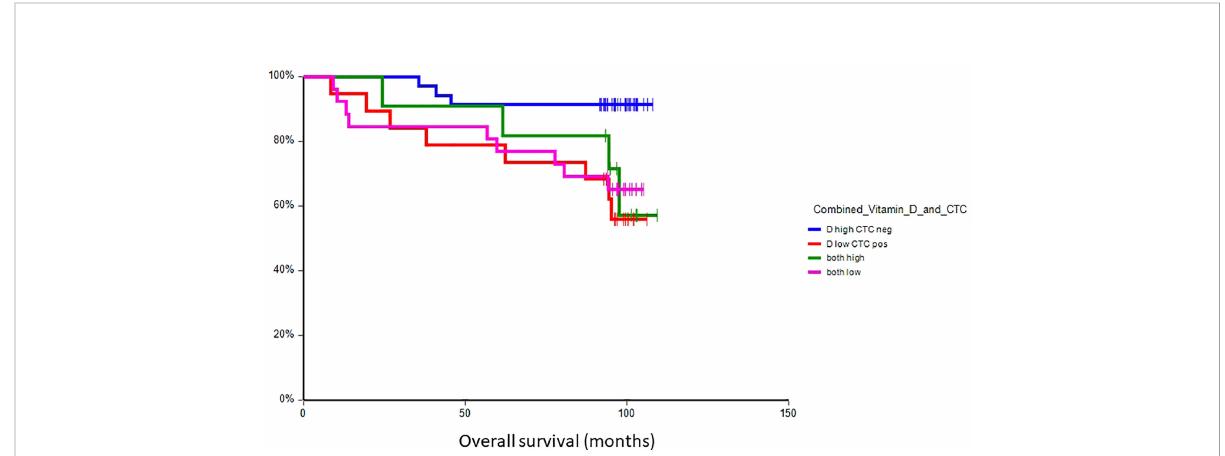
FIGURE 5 Kaplan – Meier estimates of probabilities of overall survival according to plasma vitamin D level and CTC status in primary breast cancer patients (n = 91). Patients with plasma vitamin D levels above median and undetectable CTC had signi fi cantly better OS as compared to patients with lower vitamin D levels with CTC (HR = 0.18, 95% CI 0.05 – 0.63, p = 0.004). CTC, circulating tumor cell; OS, overall